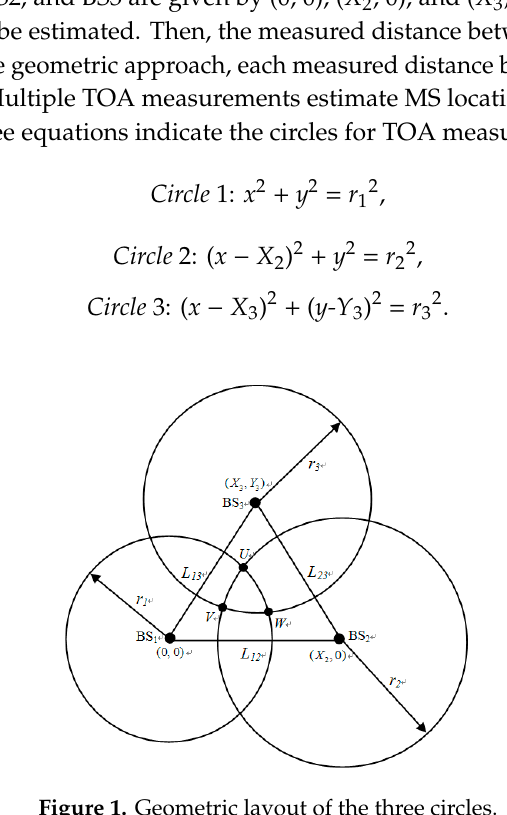
Figure 1. Geometric layout of the three circles.